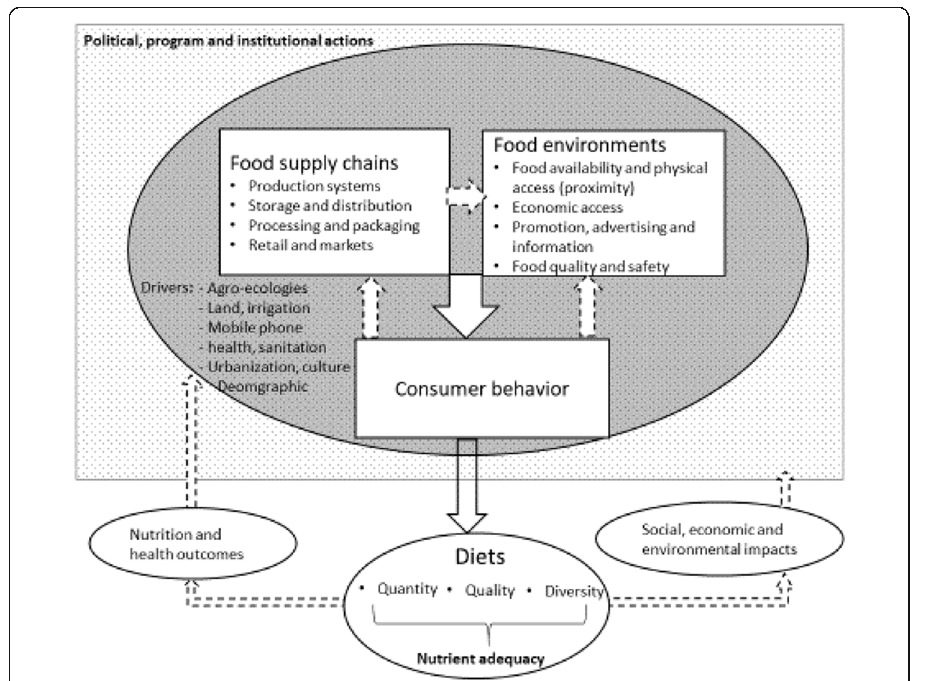
Fig. 1 Conceptual framework of food systems for diets and nutrition. Adapted from HLPE